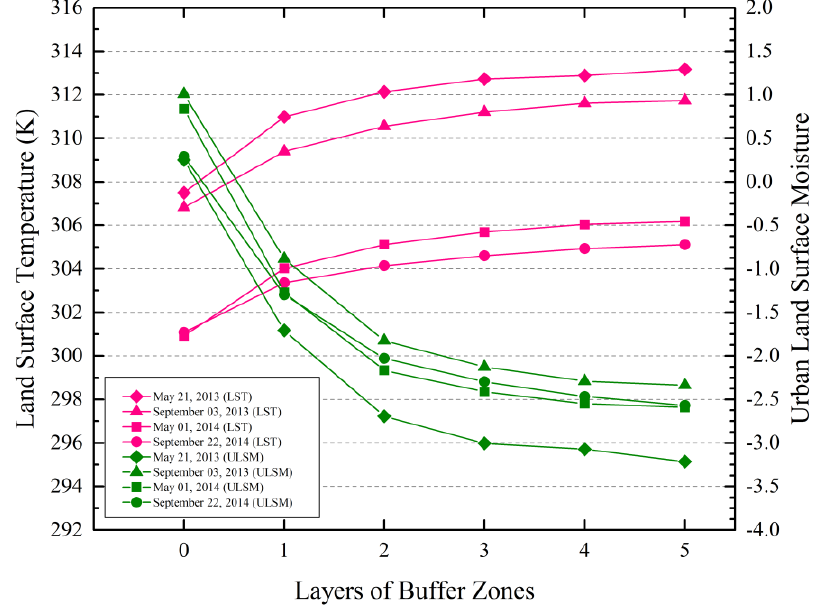
Figure 7. Average value of the land surface temperature and urban land surface moisture in core areas and in each layer of the buffer zones. The zero point on the x axis refers to a core area.